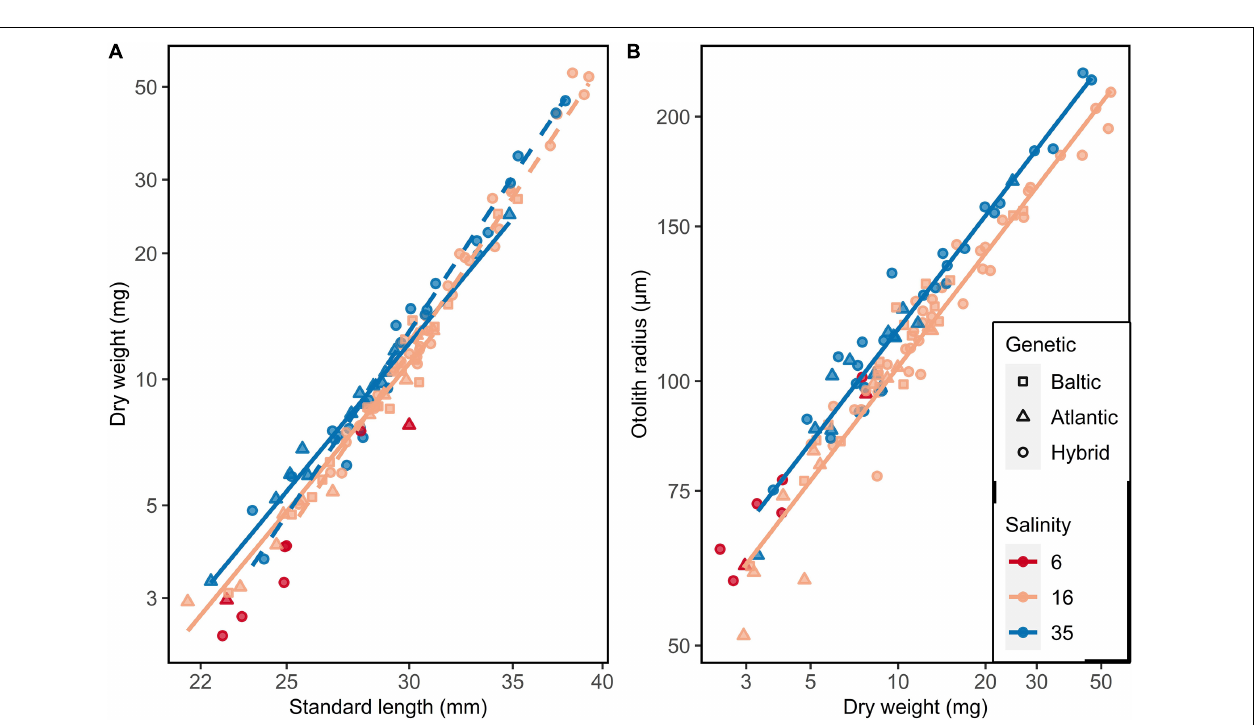
FIGURE 4 | Standard length-at-age relationship for all sampled F1 larvae. Filled symbols indicate larvae used for the otolith microstructure analysis (at age 57 and 71 for all tanks, and age 50 and 64 solely for 16 psu). Atlantic purebreds and Atlantic/Baltic hybrids were co-reared (mix) at 6, 16, or 35 psu. Baltic purebreds were separately reared at 16 psu. Lines indicate linear regression for salinity 16 (excluding Baltic purebreds) and 35 psu. Data points are jittered to reduce overlap of data points.